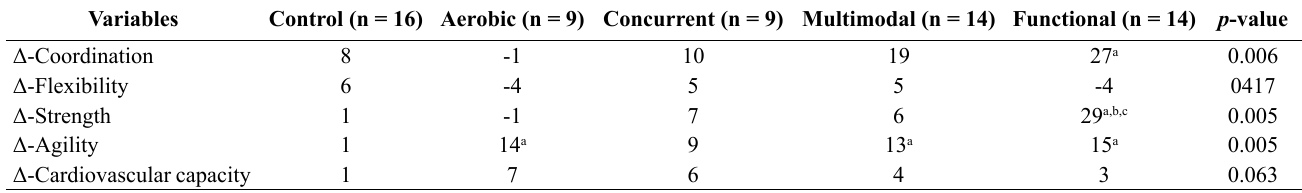
Table 3. Comparison between groups in the relative different capacities